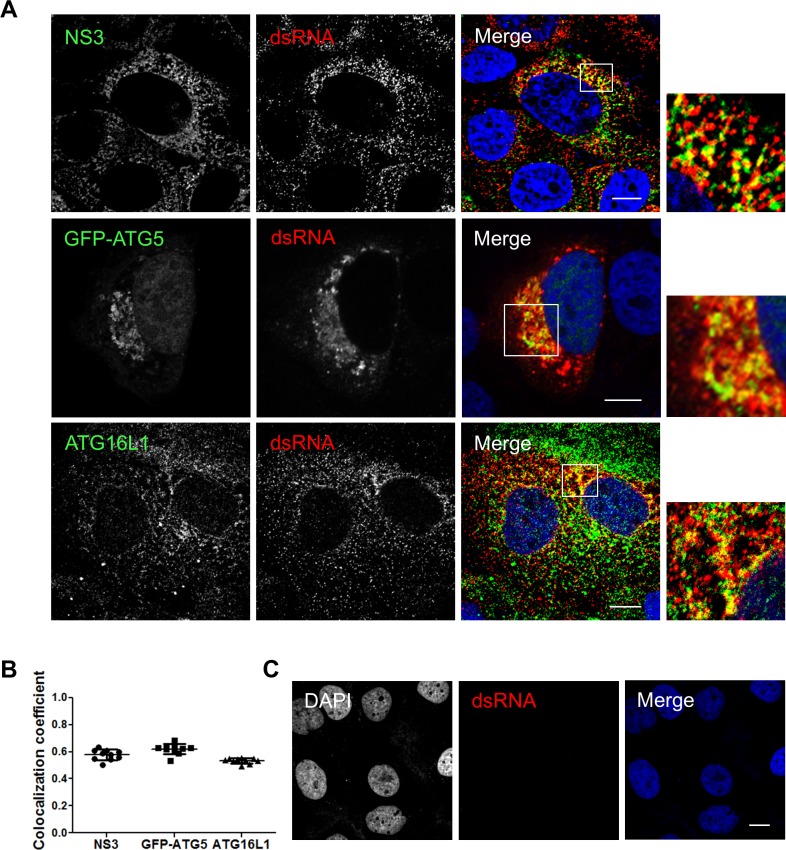
The autophagy elongation complex colocalizes with HCV replicative intermediate dsRNA.A. JFH1-infected Huh7 cells at more than 90% were immunostained for dsRNA and NS3 or ATG16L1. Alternatively, infected cells were transfected with pGFP-ATG5 and analyzed by confocal microscopy for dsRNA and GFP-ATG5. Scale bar, 10μm. B. The average of percent colocalization of NS3, GFP-ATG5 or ATG16L1 with dsRNA was determined. The values of overlapping fluorescence signals with dsRNA proteins were calculated using Manders’ colocalization coefficient (n = 5 cells, 10 arbitrary positions). C. Uninfected Huh7 cells immunostained for dsRNA. Negative staining shows specificity of dsRNA utilized in this experiment. Scale bar, 10μm.